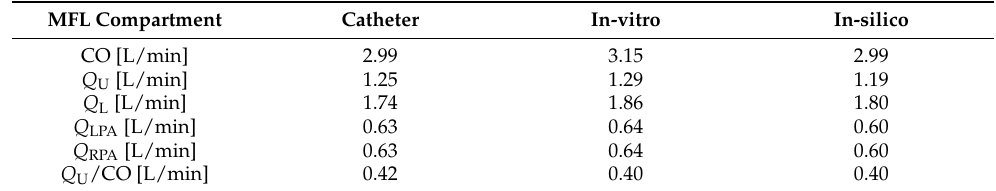
Table 6. Comparison of cycle averaged flow rate [L/min] data of patient 1 between catheter reports, in-vitro and in-silico measurements.